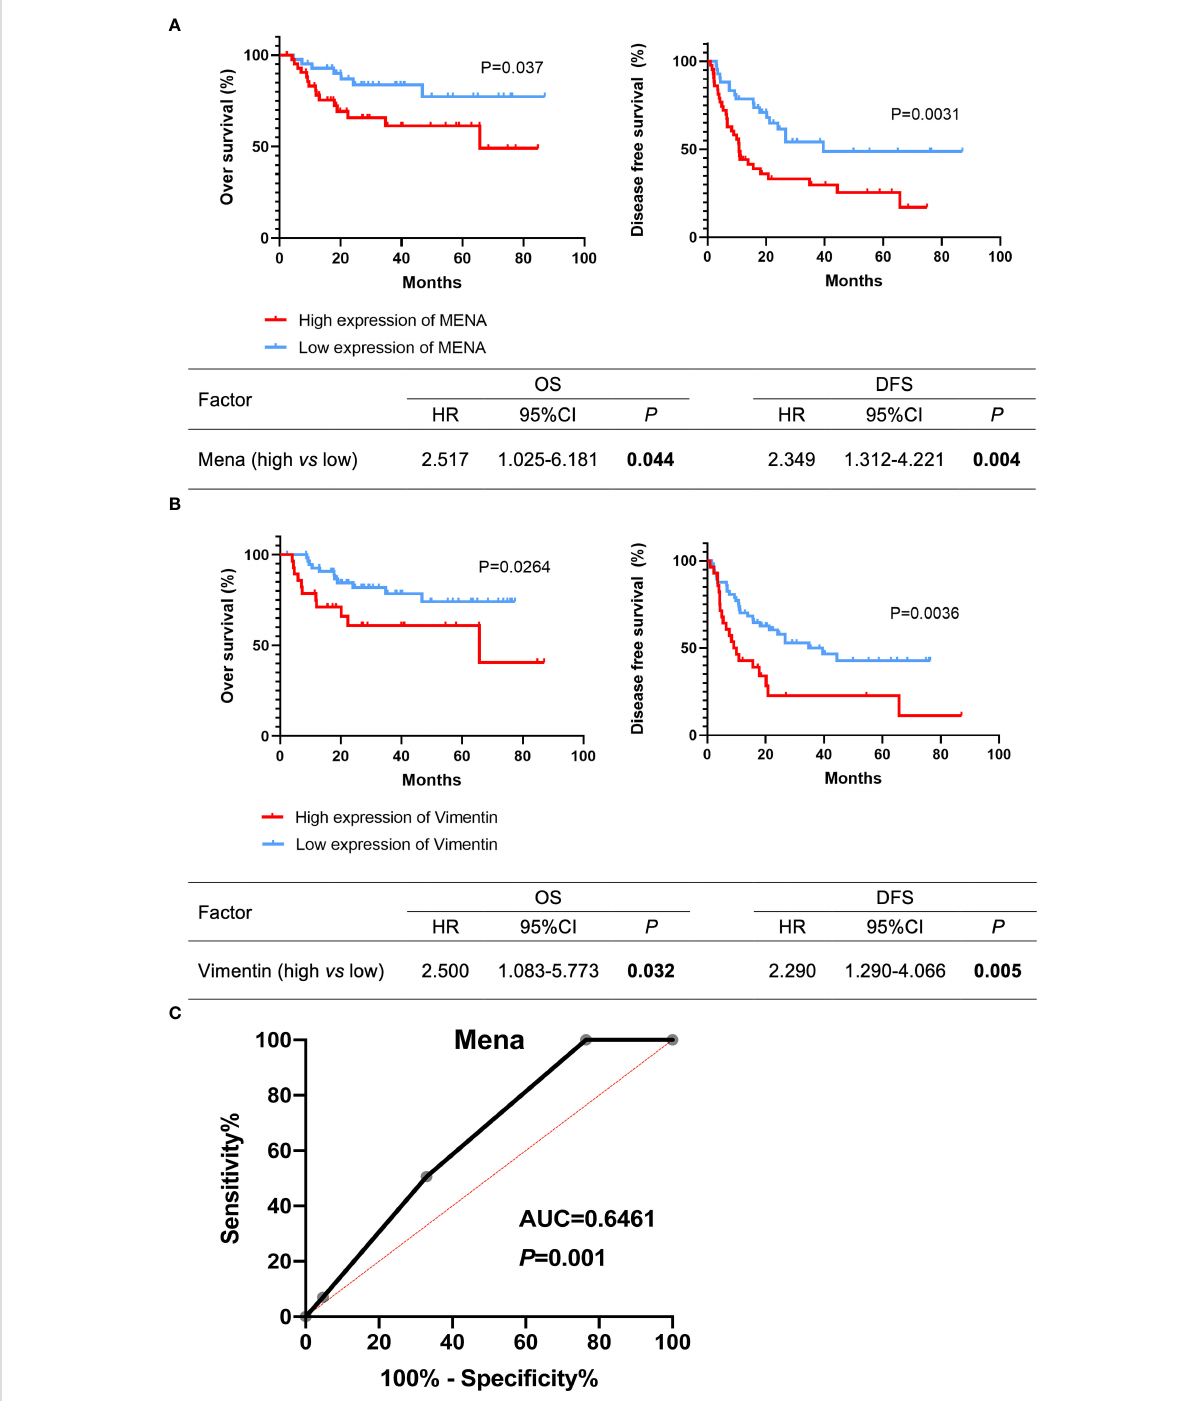
FIGURE 5 Potential prognostic value of Mena expression in OSCC patients. (A, B) Kaplan-Meier survival curves. (C) Receiver operating curves. The bold values mean that P -values <